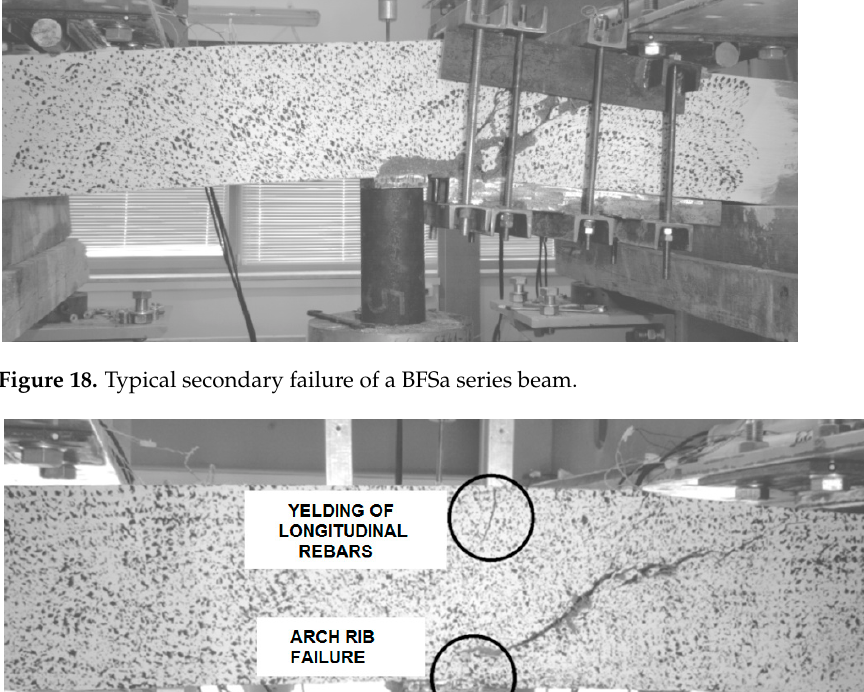
Figure 19. Example of a secondary BFSb series beams failure.